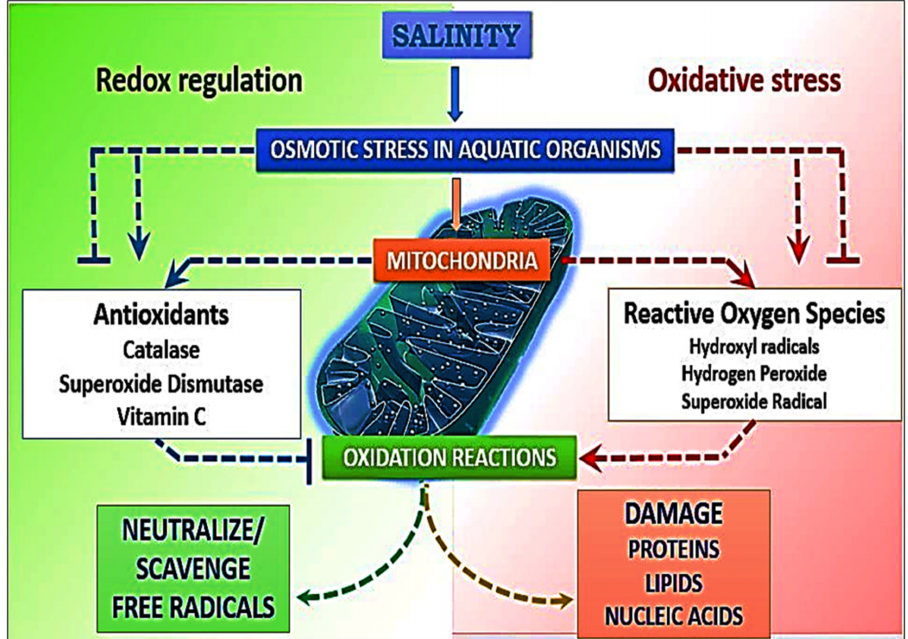
Figure 5. An overall outline of the oxidative stress responses and redox signaling in animals under salinity stress: Environmental osmotic stress can induce the generation of reactive oxygen species, but at the same time it also induces redox signaling. If the latter system is deactivated, it can lead to the alleviated expression of redox-regulating enzymes, resulting in elevated oxidative stress. Mitochondria play a pivotal role in this